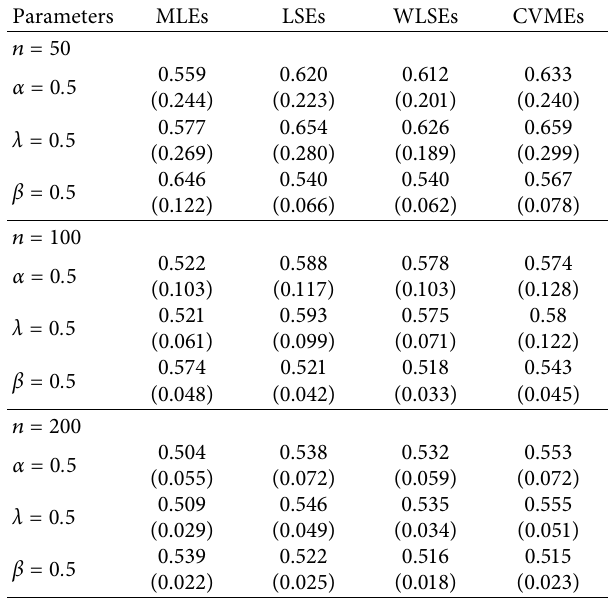
Table 1: The mean values and MSEs of the TIHLIW distribution.